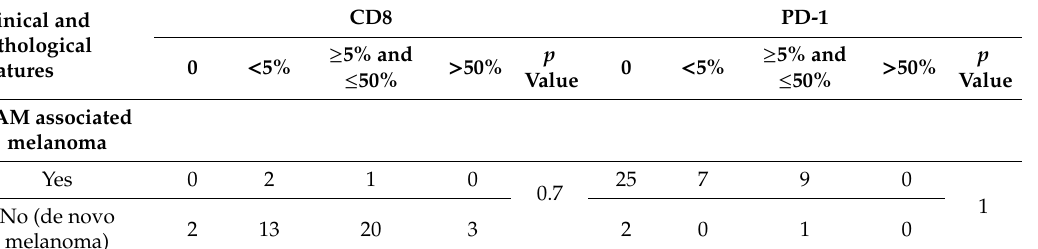
Table 2. Correlation between the criteria for histological prognosis and the number of CD8 + and PD-1